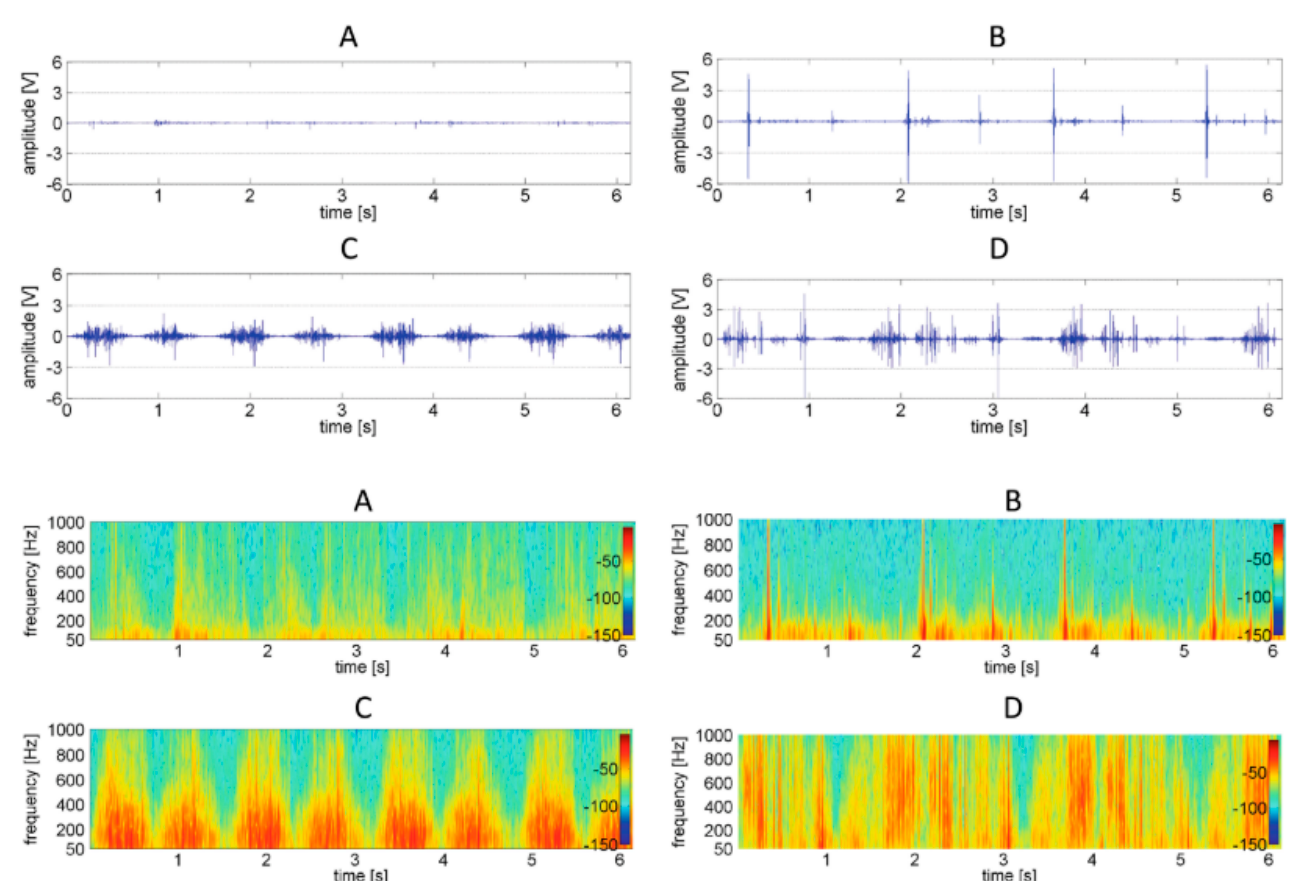
Figure 5. The time domain waveforms and their respective spectrograms from [17]. Here, the different patellofemoral diseases were investigated: ( A ) healthy knee; ( B ) knee with lateral patellar compression syndrome; ( C ) knee with condromalacia; and ( D ) knee with patellofemoral joint arthritis.